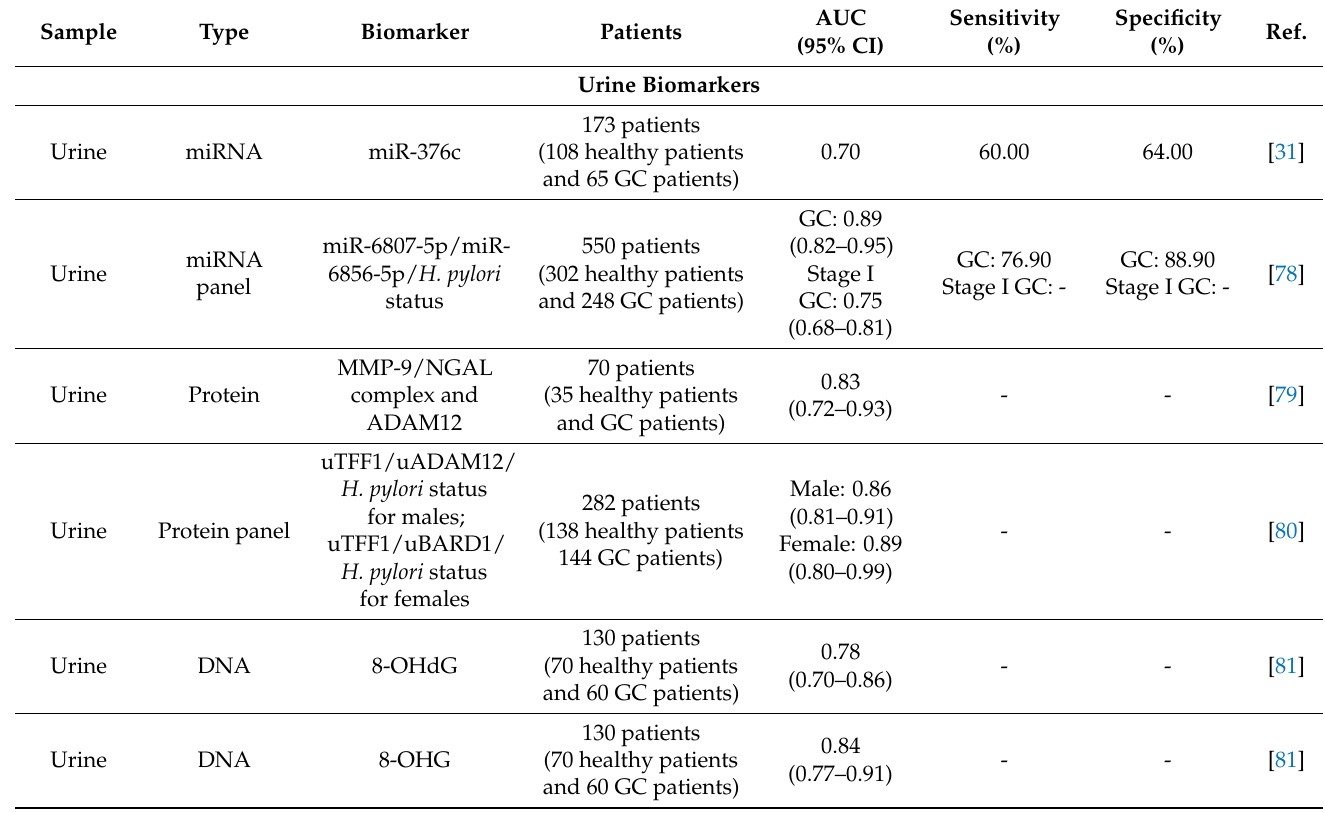
Table 3. Summary of potential urine biomarkers for gastric cancer screening and early